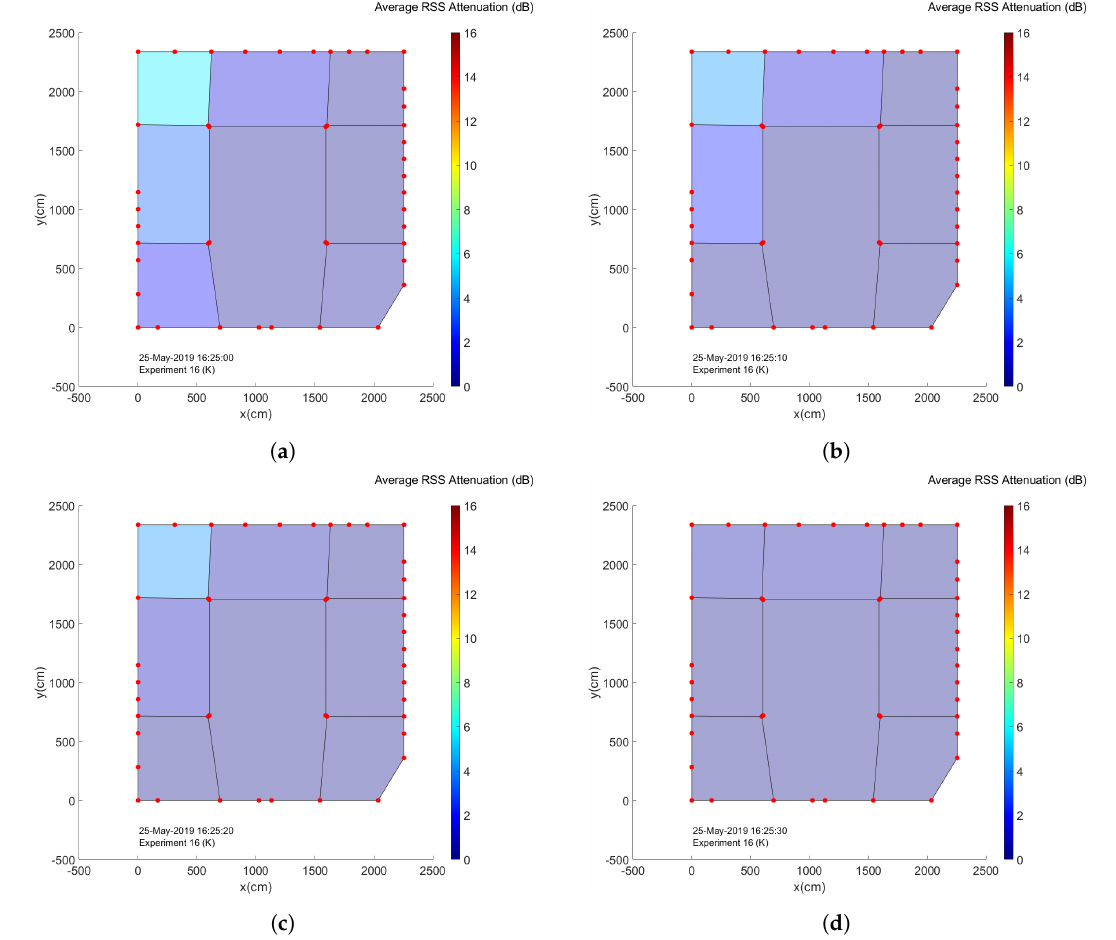
Figure 23. A set of attenuation maps providing an overview of the average RSS attenuation within each subregion near the end of the experiments, from ( a – d )